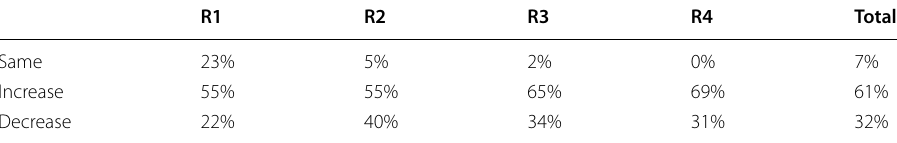
Table 8 Comparison of the follow-up system assessment and initial system assessment R1 R2